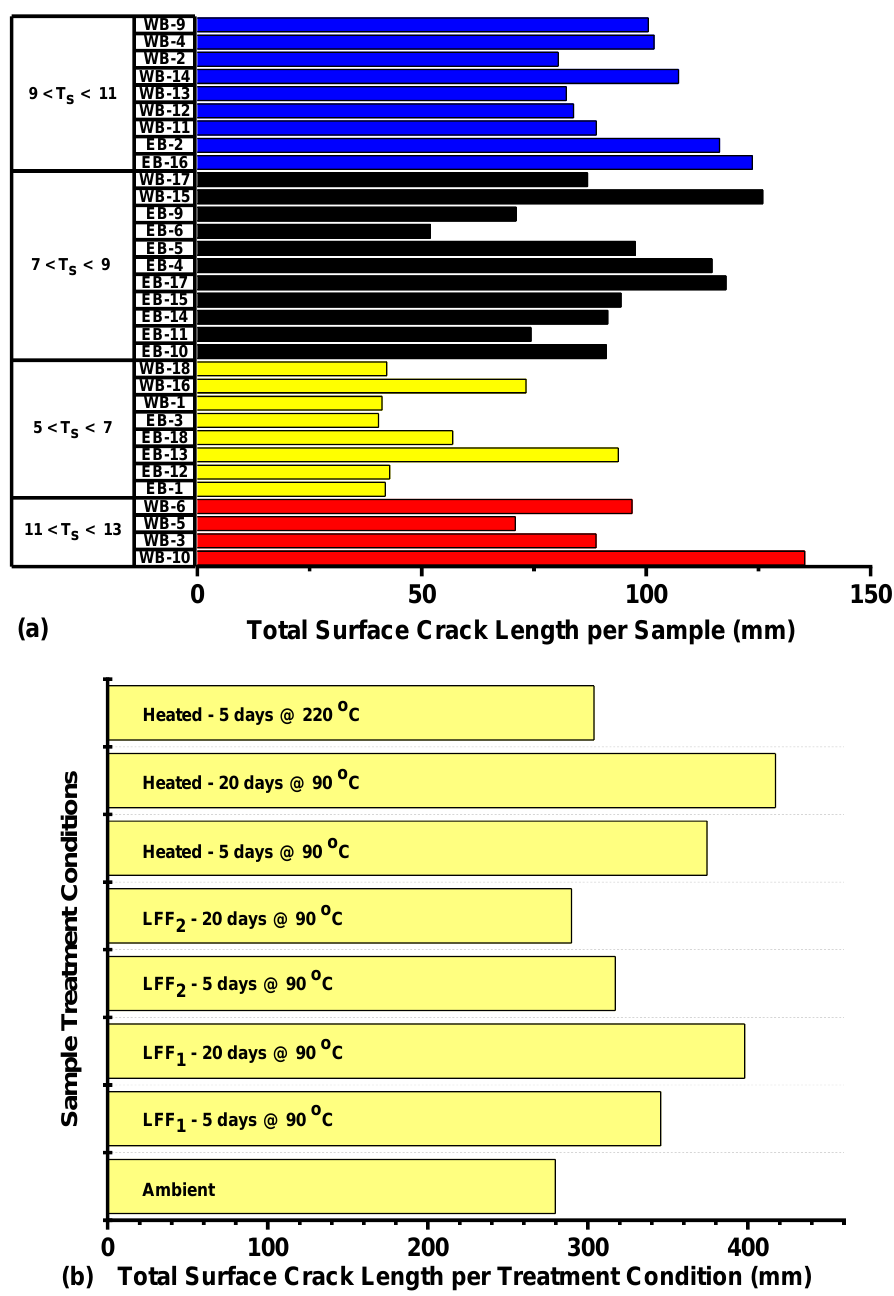
Figure 22. ( a ) Total surface crack length per sample for Groups 1–4 based on respective samples’ tensile strengths, and ( b ) Total surface crack length per treatment condition for the various sample sets.